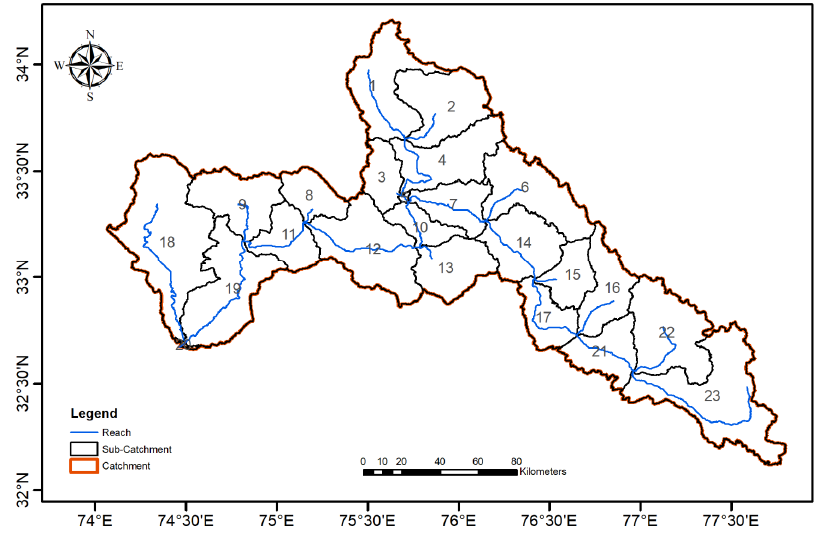
Figure 6. Delineation of the study catchment.